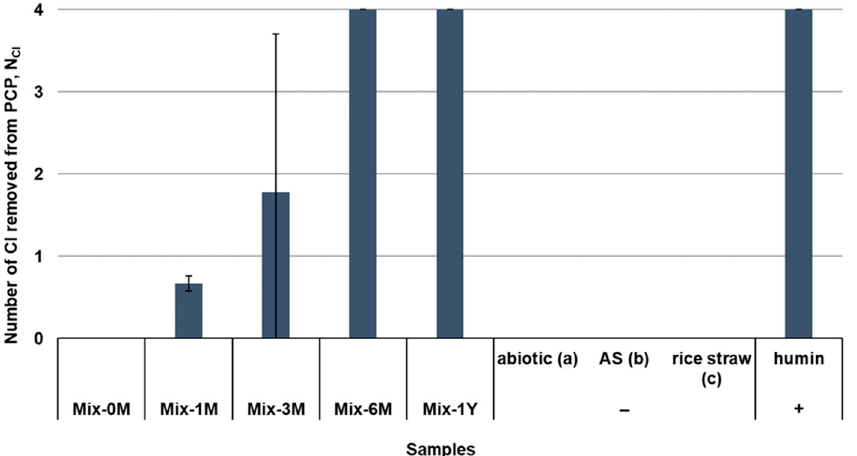
Figure 1. Changes in the EEM functionality of the rice straw-artificial soil mixtures with 0, 1, 3, 6 months, or 1 year of humification (Mix-0M, Mix-1M, Mix-3M, Mix-6M, and Mix-1Y), as shown by N Cl . The value indicates the mole numbers of Cl removed from one mole of PCP, calculated based on the proportion of PCP and its dechlorination metabolites detected in the EEM material-dependent PCP- dechlorinating cultures (third generation) (Calculation S1). Phenol was not included as a metabolite for the calculation. Positive control with humin as EEM material is shown by the symbol (+). Negative controls are indicated by the symbol ( − ). Negative control-a shows the representative result of abiotic controls with the Mix samples with different humification periods (Figure S6), negative control-b